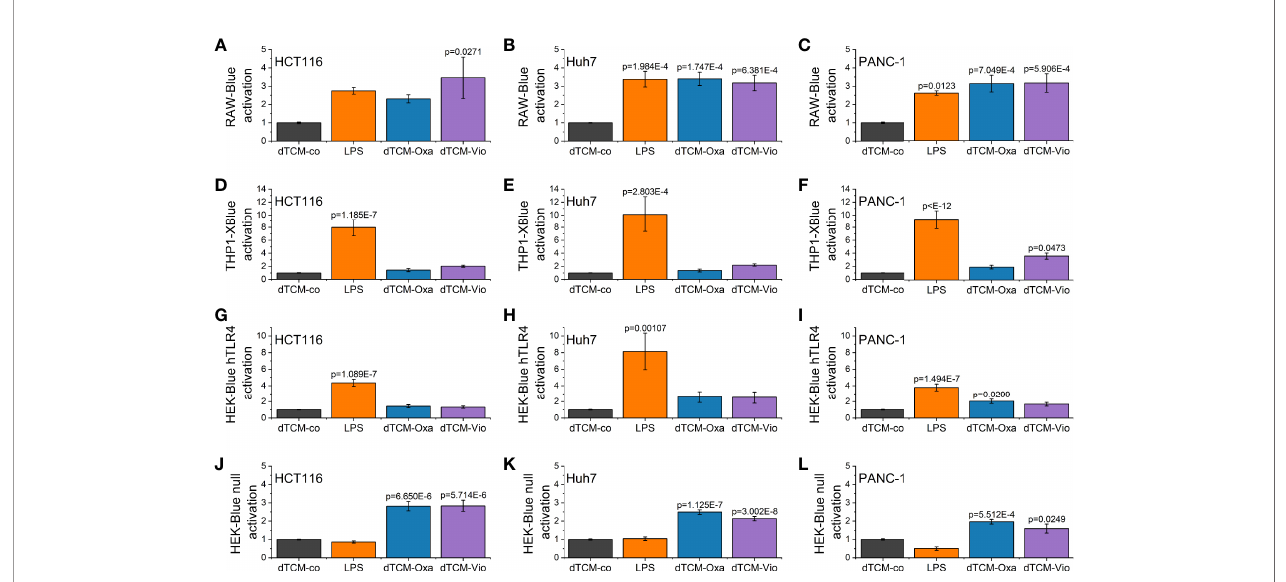
FIGURE 4 | Macrophage activation by violacein-killed tumor cell supernatant. HCT116, Huh7, and PANC-1 cells were treated with 50 µM violacein or oxaliplatin for 4 h before the media was changed. Then, 24 h after treatment, supernatants from untreated (co) and compound-treated cells were collected, and dead cells were removed. (A-C) RAW-Blue ™ , (D-F) THP1-XBlue ™ , (G, H) HEK-Blue ™ hTLR4, and (J-L) HEK-Blue ™ Null2 reporter cells were incubated with the respective dead tumor cell-conditioned medium (dTCM, 50% v/v) or LPS (100 ng/ml for RAW-Blue ™ and 10 ng/ml for THP1X-Blue ™ , HEK-Blue ™ hTLR4, and HEK-Blue ™ Null2) for 24 h. The activation of the reporter cells was determined by colorimetric QUANTI-Blue ™